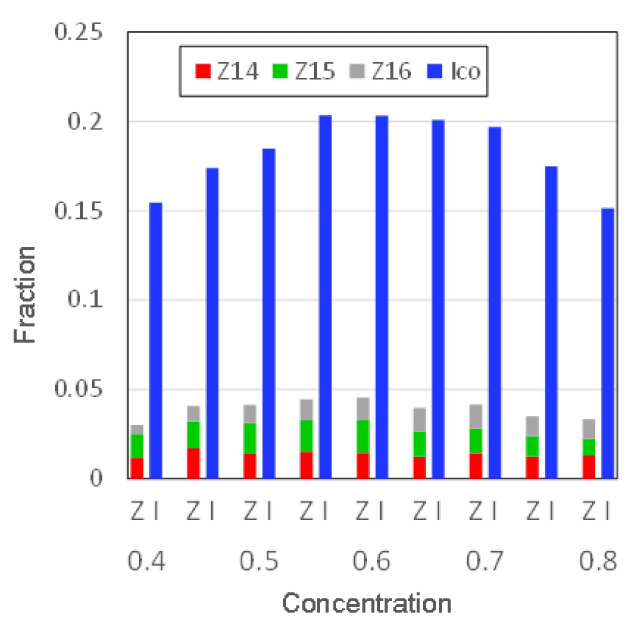
Figure 6. Concentration dependence of the population of the I- and Z-clusters in the glassy phases of the r BB = 0.8 A 1 − x B x system formed by middle-cooling